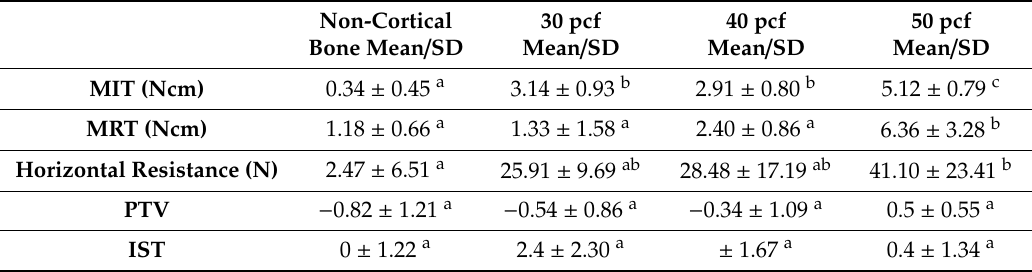
Table 2. Reduction in primary stability between initial insertion and re-insertion of miniscrews into cortical bone with varying